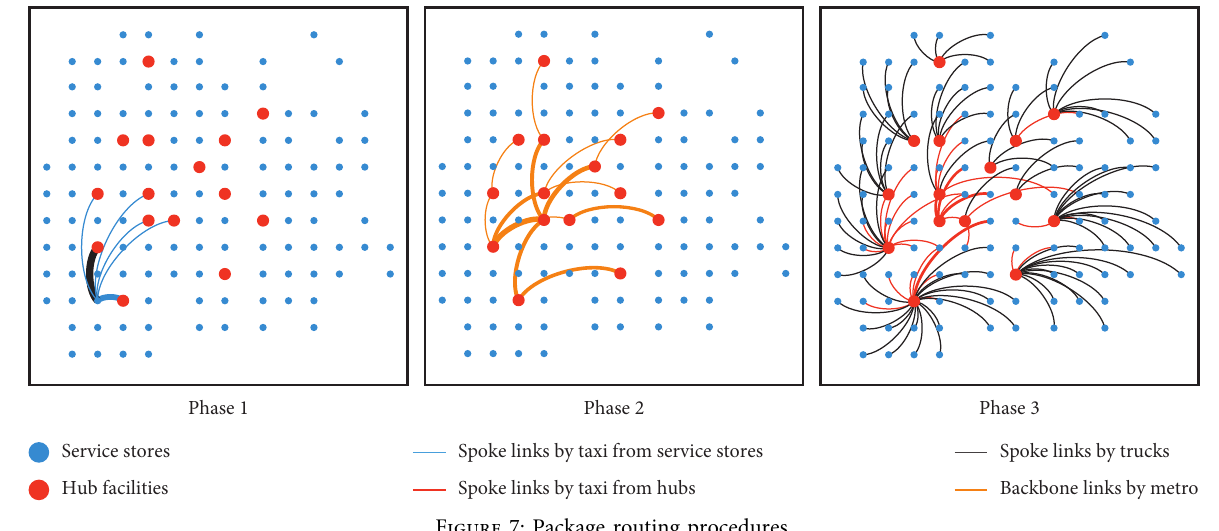
Figure 7: Package routing procedures.